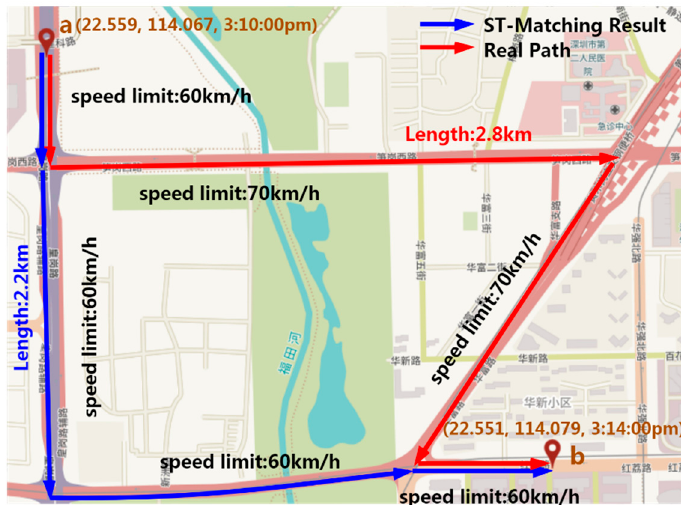
Figure 1. Example of map matching result based on spatial and temporal model for a low-sampling-rate GPS trajectory.